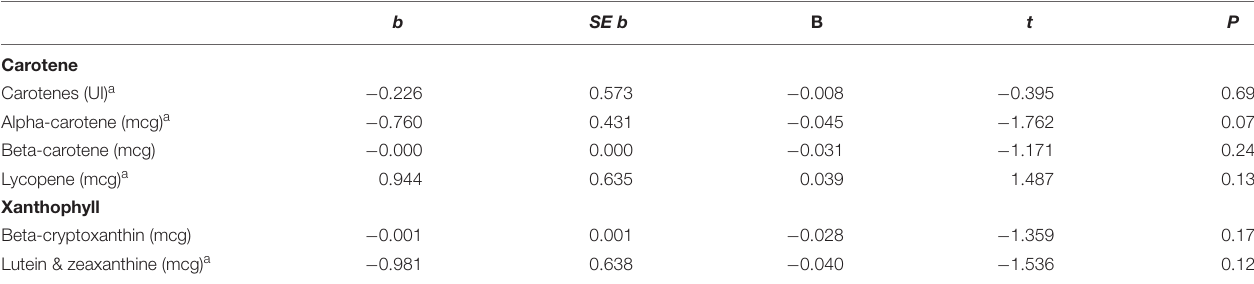
TABLE 5 | Linear regressions between each carotenoid type and recollection accuracy